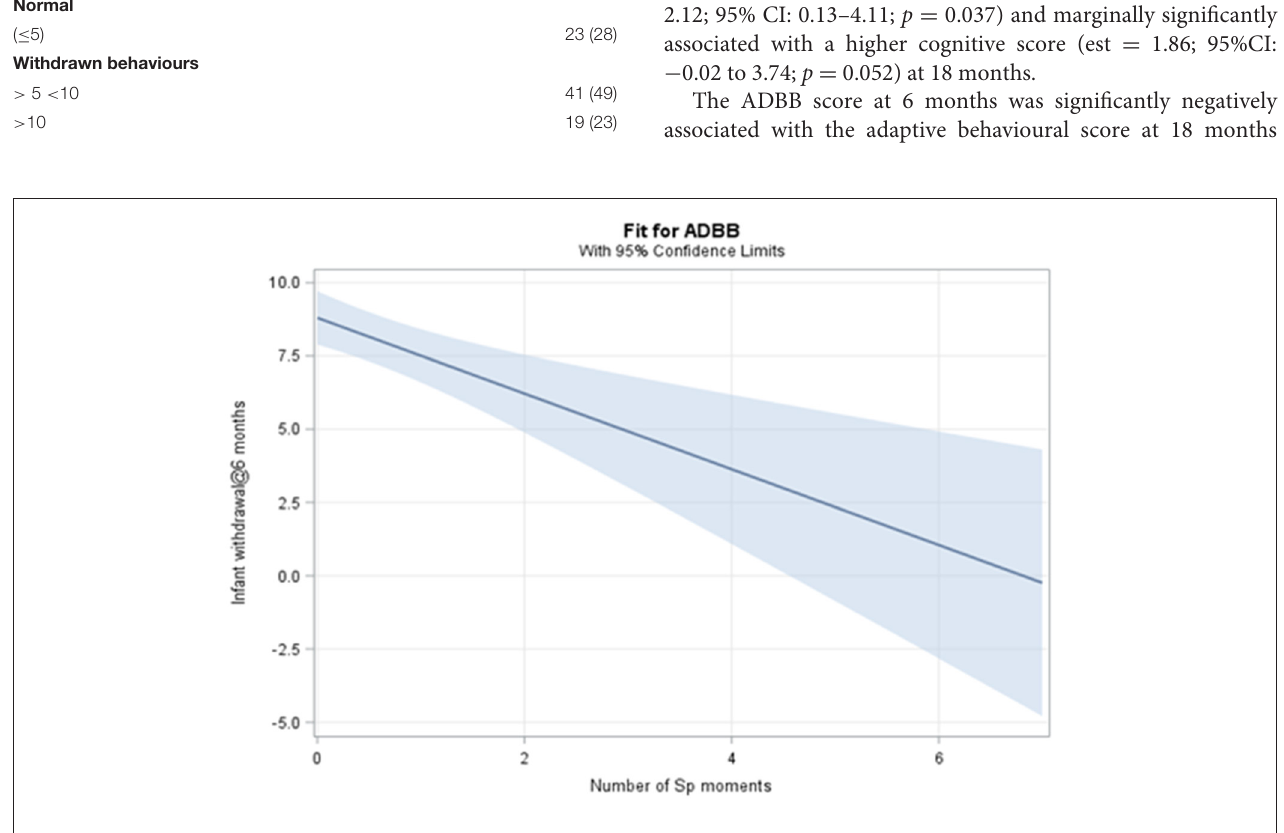
FIGURE 4 | SP moments and association with Infant